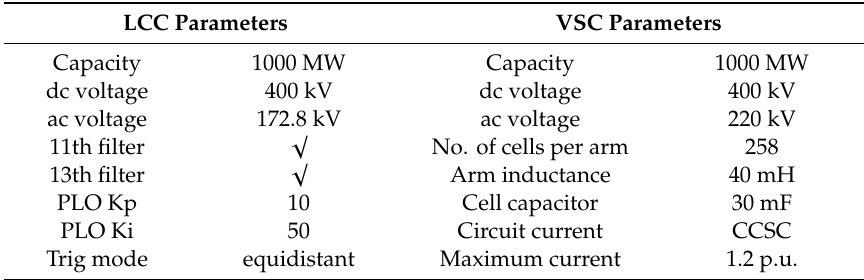
Table 1. Hybrid HVdc System